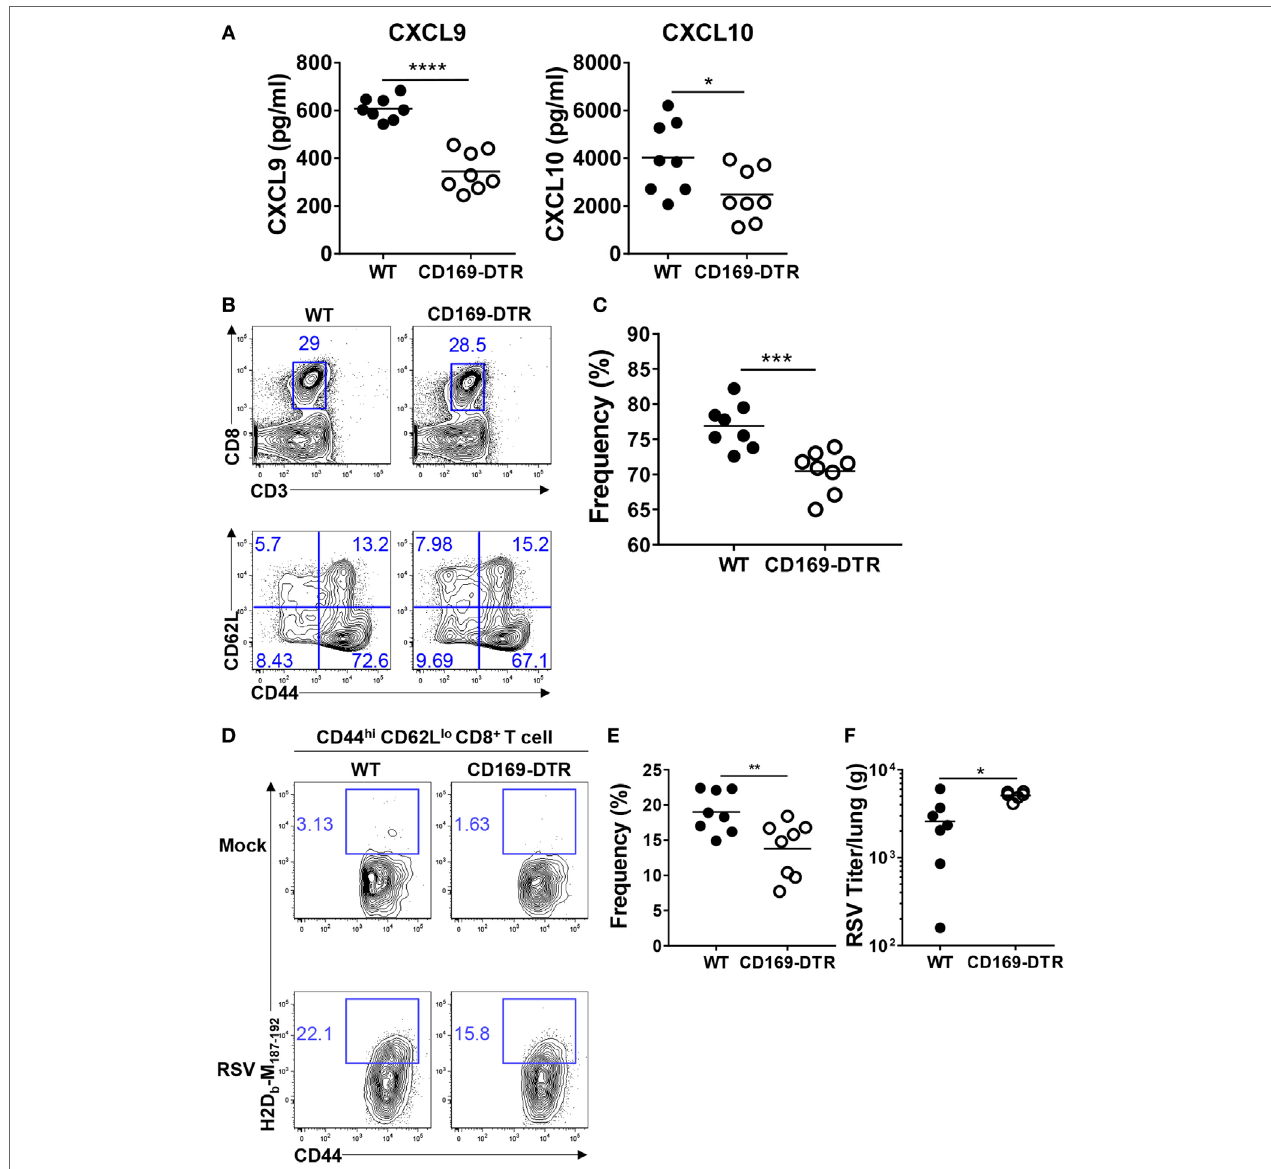
FigUre 6 | CD169 + cell depletion reduces the recruitment of effector CD8 + T cells in lungs after respiratory syncytial virus (RSV) infection. At the indicated time points after RSV infection, bronchoalveolar lavage fluid was collected from diphtheria toxin-treated wild-type (WT) and CD169-diphtheria toxin receptor (DTR) mice. The levels of CXCL9 and CXCL10 in the lavage fluids were measured by ELISA (a) . Seven days after RSV infection, the frequencies of CD8 + T cells (B) and CD44 hi CD62L lo CD8 + T cells (c) were assessed by flow cytometry. (D) RSV M peptide-specific CD44 hi CD62L lo CD8 + T cells were detected by flow cytometry. (e) Frequencies of CD44 hi CD62L lo tetramer + CD8 + T cells were quantified from flow cytometry data of RSV-infected mice. (F) Five days after infection, RSV viral titers from lung homogenates were measured on HEp-2 cells. Each dot represents an individual mouse ( n = 8 in each group). Statistically significant differences between groups are indicated: * P < 0.05, ** P < 0.01, *** P < 0.001, and **** P < 0.0001. Data are representative of two independent